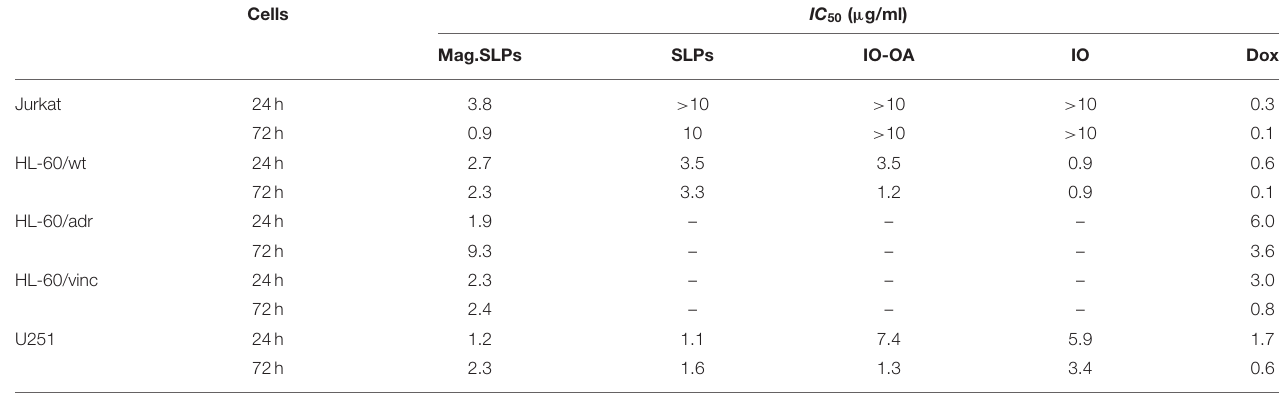
TABLE 2 | Half maximal inhibitory concentration ( IC 50 ) for various particles and doxorubicin (Dox) toward several tumor cell lines determined by trypan blue exclusion test. Cells IC 50 ( µ g/ml) Mag.SLPs SLPs IO-OA IO Dox Jurkat